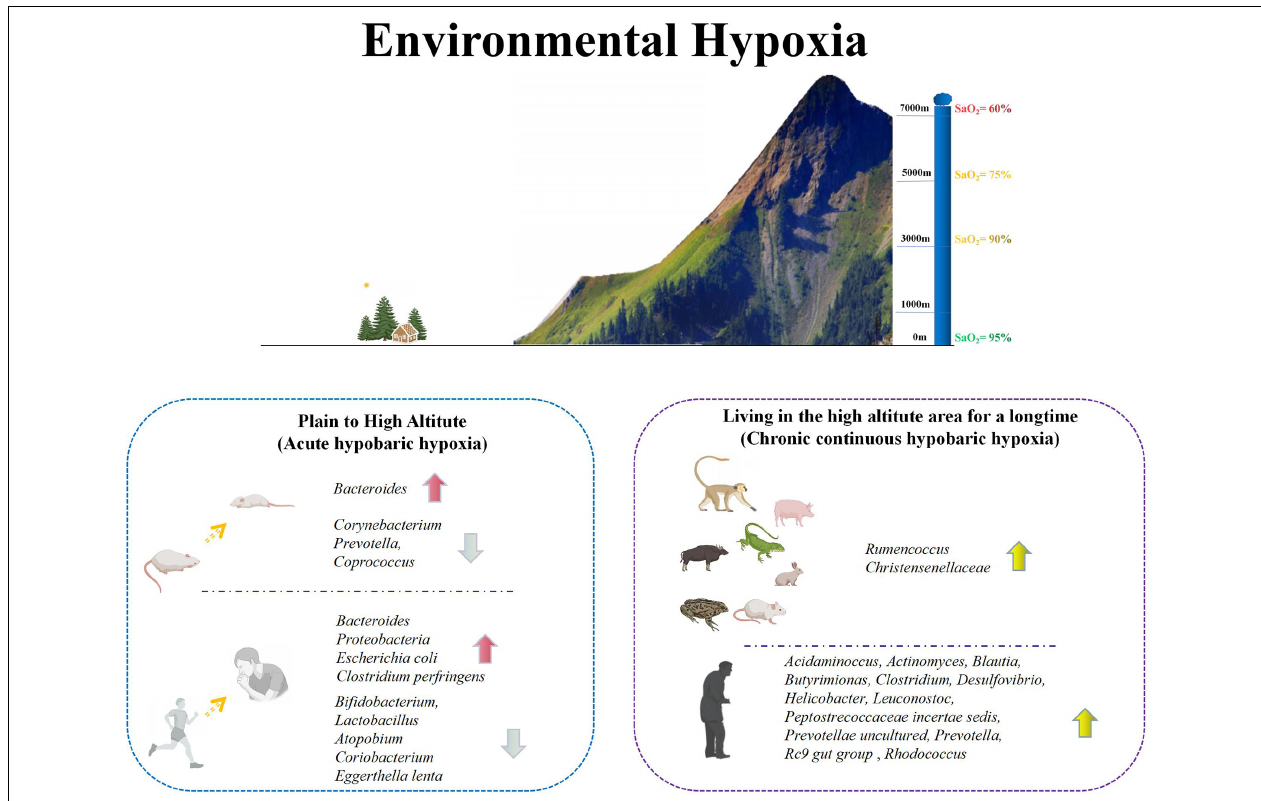
FIGURE 1 | Changes of intestinal microbiota in animals and humans under environmental hypoxia. Environmental hypoxia can be divided into acute hypobaric hypoxia and chronic hypobaric hypoxia. Acute hypobaric hypoxia usually refers to the environment from plain to plateau. In this case, the intestinal microorganisms in animals and human will change greatly. In animals, Bacteroides increased significantly, while Corynebacterium , Prevotella and Coprococcus decreased significantly. The acute changes in human were mainly reflected in the significant increase of Bacteroides , Proteobacteria, Escherichia coli and Clostridium perfringens, and the significant decrease of some probiotics, including Bifidobacterium, Lactobacillus, Atopodium, Coriobacterium , and Eggerthella lenta . Chronic hypobaric hypoxia mainly refers to animals and people living in plateau environment for a long time. There is a high abundance of Rumencoccus and Christensenellaceae in animals living in plateau environment for a long time. However, there are some differences between human living in plateau environment and the plain, mainly in the higher abundance of Acidaminocus, Actinomyces, Blautia, Butyrimionas, Clostridium, Desulfovibrio, Helicobacter, Leuconostoc, Peptostrecoccaceae incertae sedis, Prevotellae uncultured, Prevotella, Rc9 gut group and Rhodococcus . Based on the above two kinds of hypoxia conditions, it shows that hypoxia can indeed affect the intestinal microorganisms in vivo